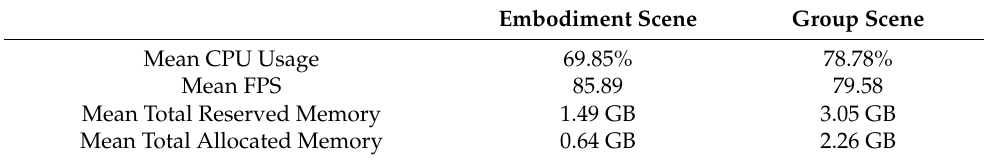
Table A6. Mean results for Test Condition